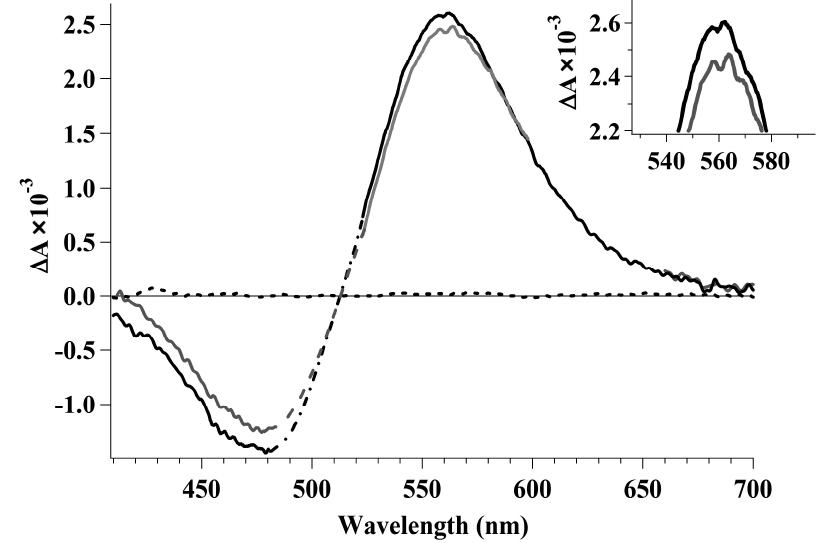
Figure 2. Differential spectra of photo-induced rhodopsin absorption obtained under the effect of a one-pump pulse of 500 nm ( pump1 ) (black curve) and two pump pulses of 500 and 620 nm ( pump1 and pump2 ) (grey curve) that follow with a 200-fs time delay and with a probe pulse time delay of 100 ps. For the control, a similar spectrum of completely bleaching rhodopsin affected by a single pump pulse of 500 nm (dashed curve) was registered. In the spectral regions of pump pulses, experimental curves were completed. Insert : expanded part of the Batho 535 maximum absorption